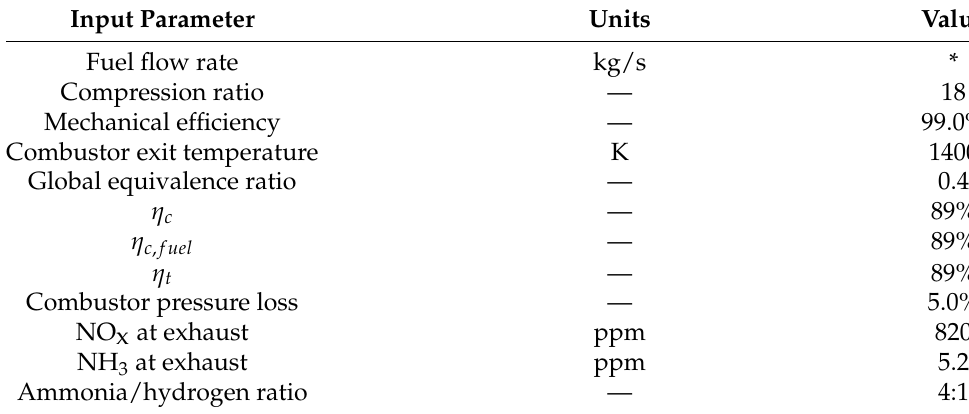
Table 4. The input parameters for the GT engine model based on the literature values [53–55]. The desired fuel flow rate is the primary variable, but all values can be changed to reflect new experimental data. * The fuel flow rate is altered until the effective power output is equal to the required power as defined by Section